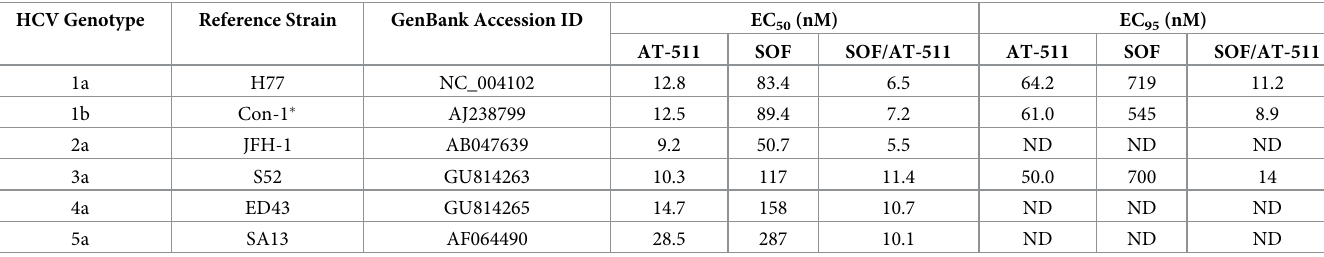
When several HCV laboratory strains and clinical isolates containing the C316N, L159F or S282T resistance-associated variants (RAVs) were tested using the PhenoSense assay, the EC and EC values were, respectively, 8- and 10-fold higher for SOF compared to AT-511, except 95 for the three strains containing the S282T genetic variation (Table 3). For those with this